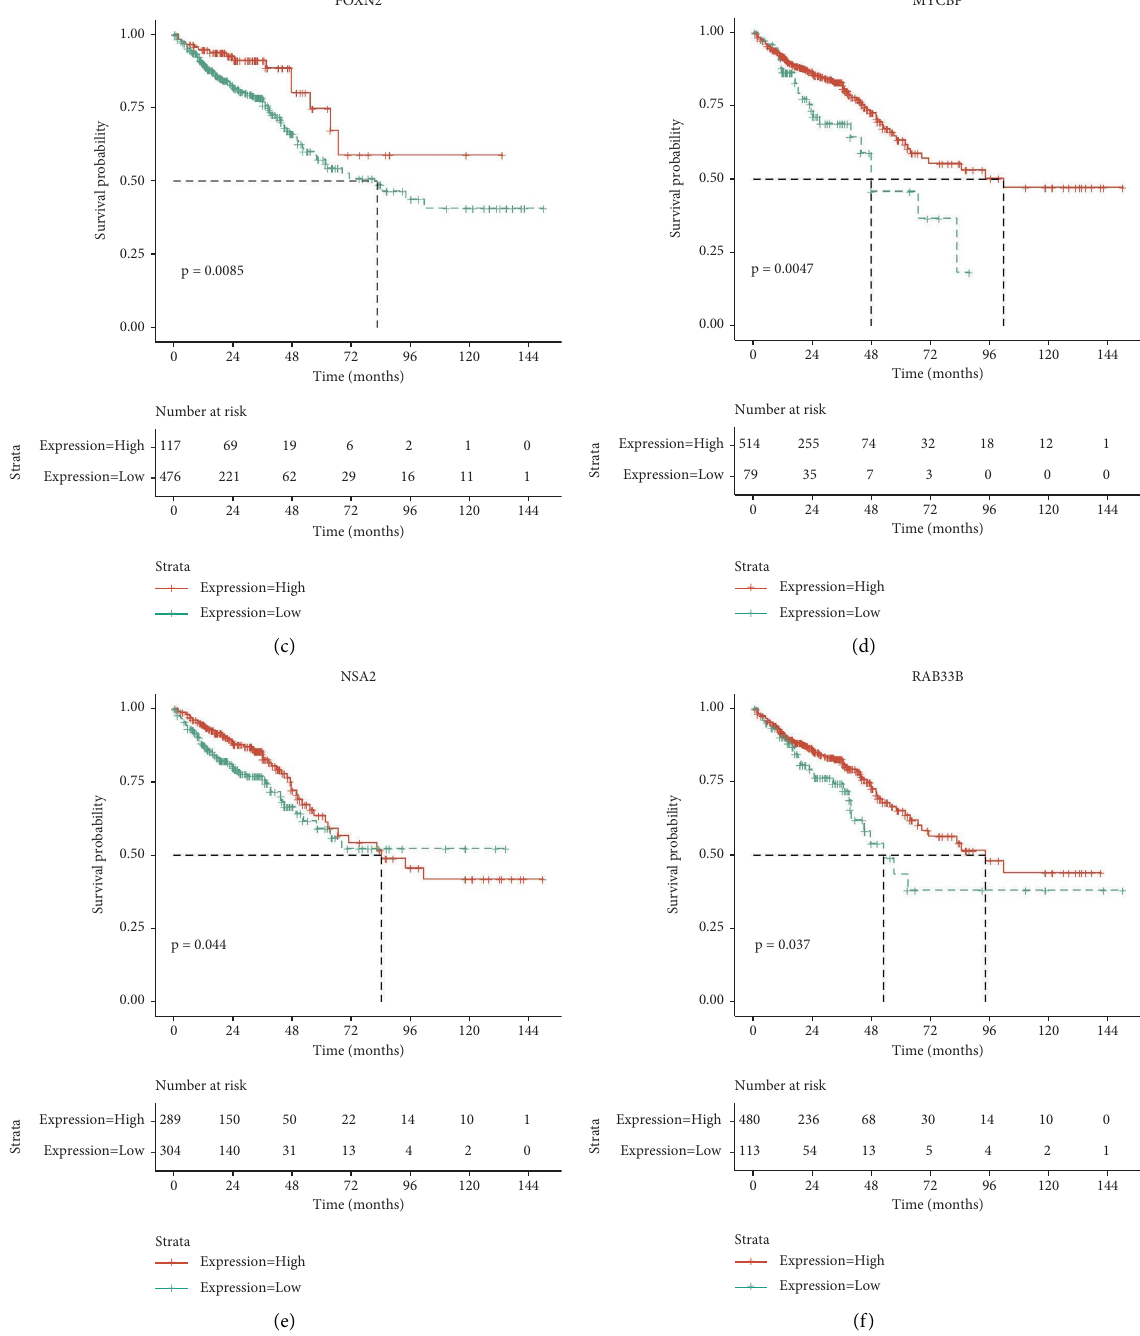
Figure 7: Kaplan–Meier survival curves of 10 overlapped genes. (a) DESI1 . (b) DIRAS2 . (c) FOXN2 . (d) MYCBP . (e) NSA2 . (f) RAB33B